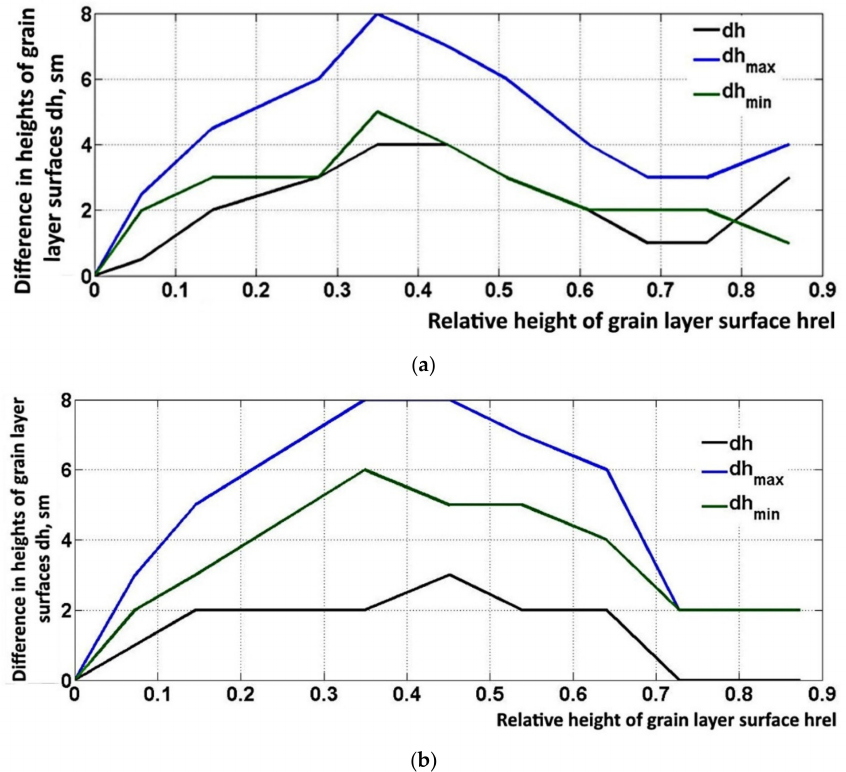
Figure 8. Change of difference in heights for upper borders of grain layer’s upper surfaces, in the course of grain flowing downwards: ( a ) outlet hole cross-section 0.0011 m 2 ; ( b ) outlet hole cross-section 0.0042 m 2